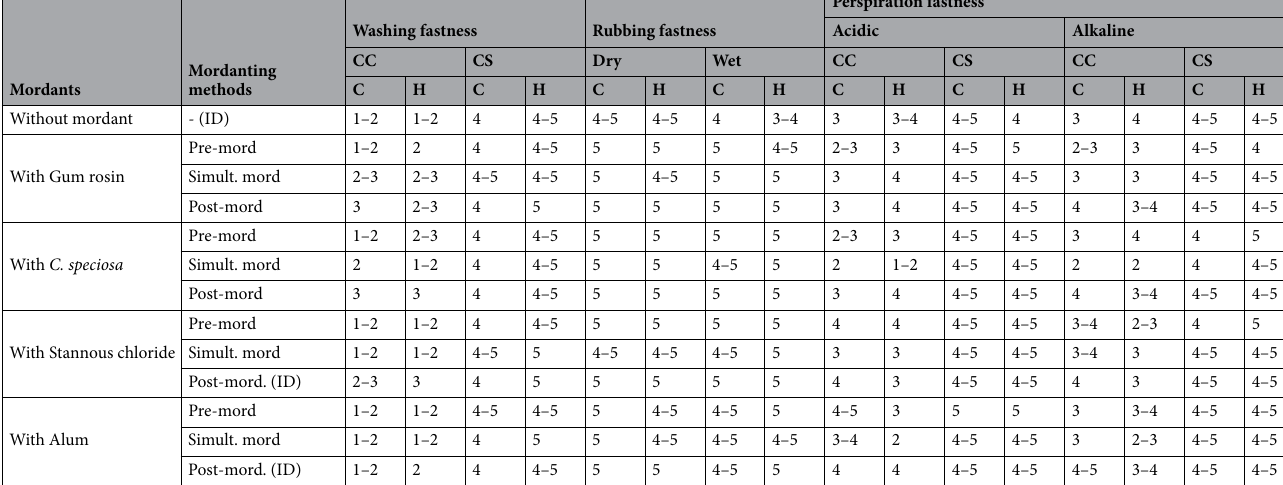
Table 6. Colorfastness of the recycled madder dyed two fabrics. CC, Color change; CS, Color staining; C, Cotton; H, Hemp; ID, Indigenous recycled madder dyeing; Pre-mord, Pre-mordanting; Simult. mord., Simultaneous mordanting; Post-mord, Post